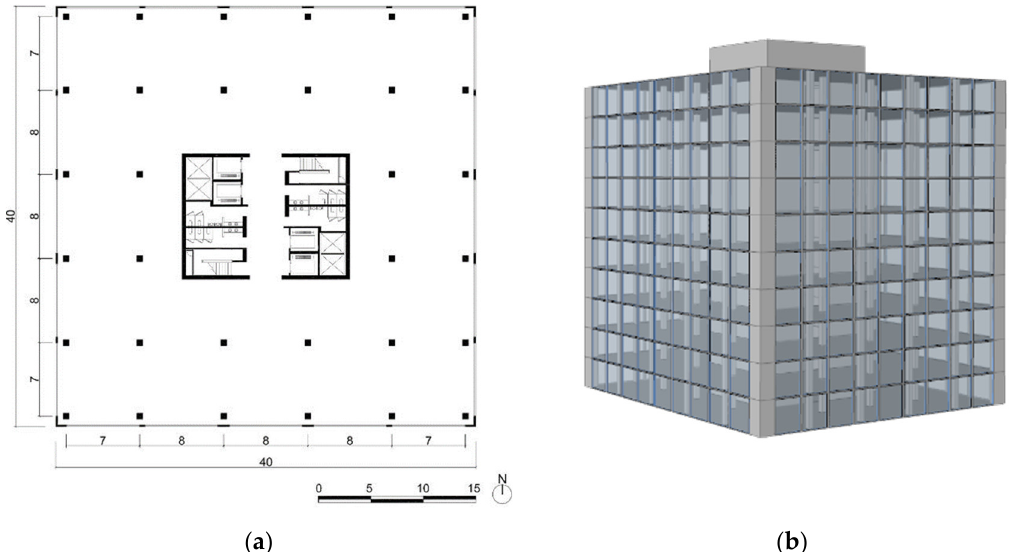
Figure 7. Research object. ( a ) Standard floor plan of an office building (unit: m); ( b ) Perspective (WWR = 80%).